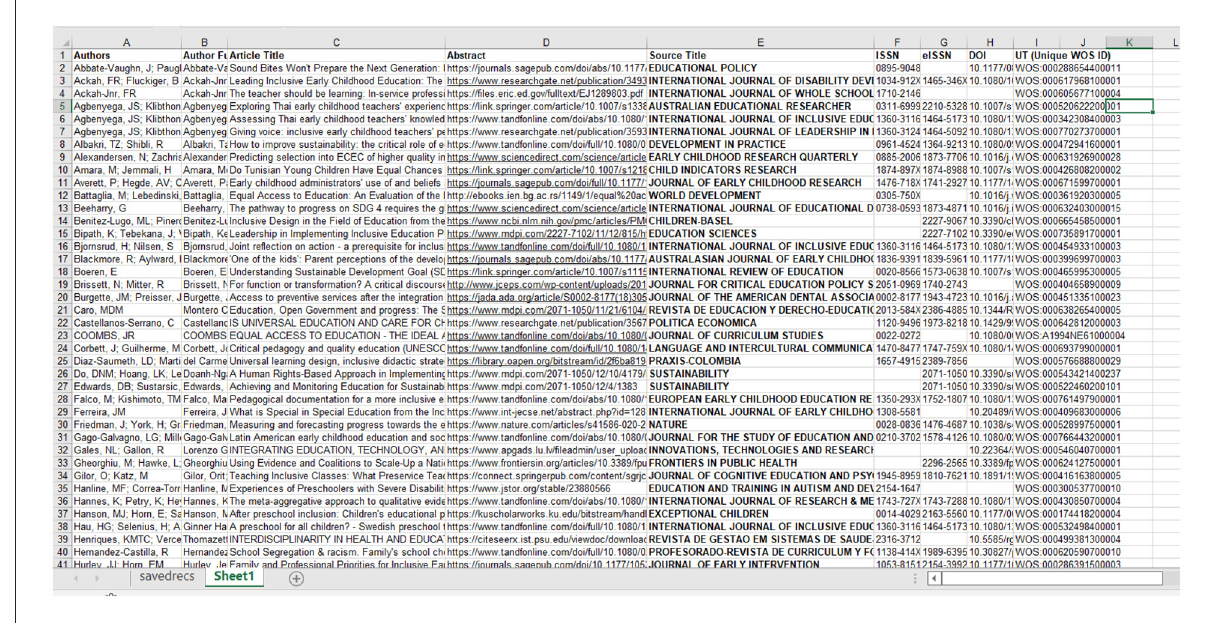
FIGURE2 Sample of Studies on qualitative and inclusive ECEC